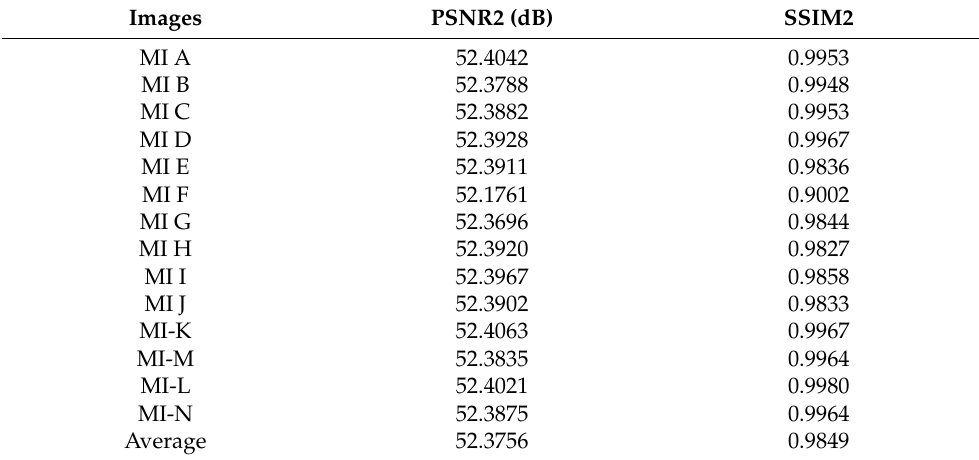
Table 3. Objective quality metrics obtained using the proposed method.